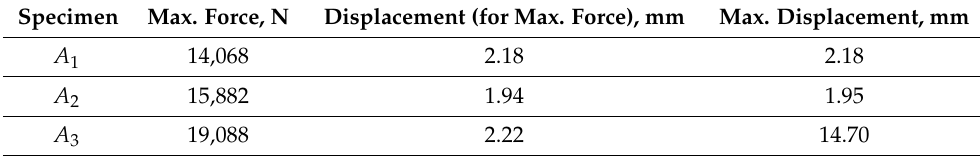
Table 2. Results obtained from three-point bending tests of fibre concrete